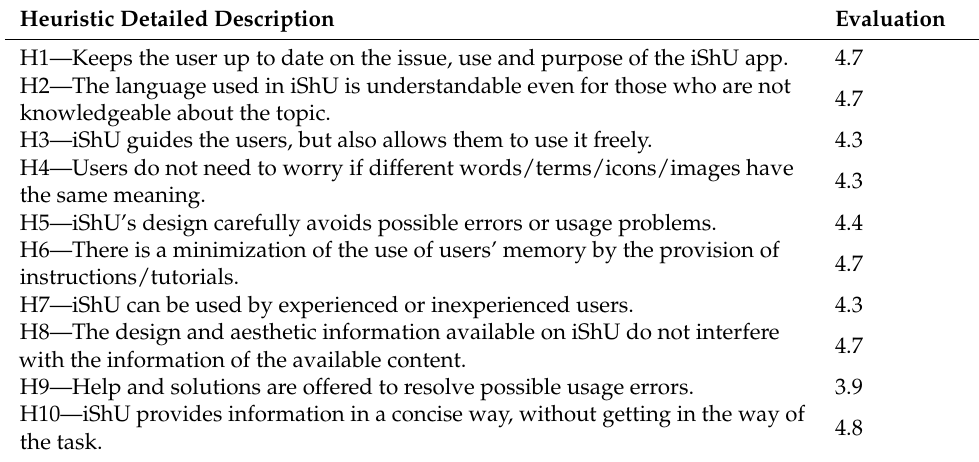
Table 5. Median of each heuristic